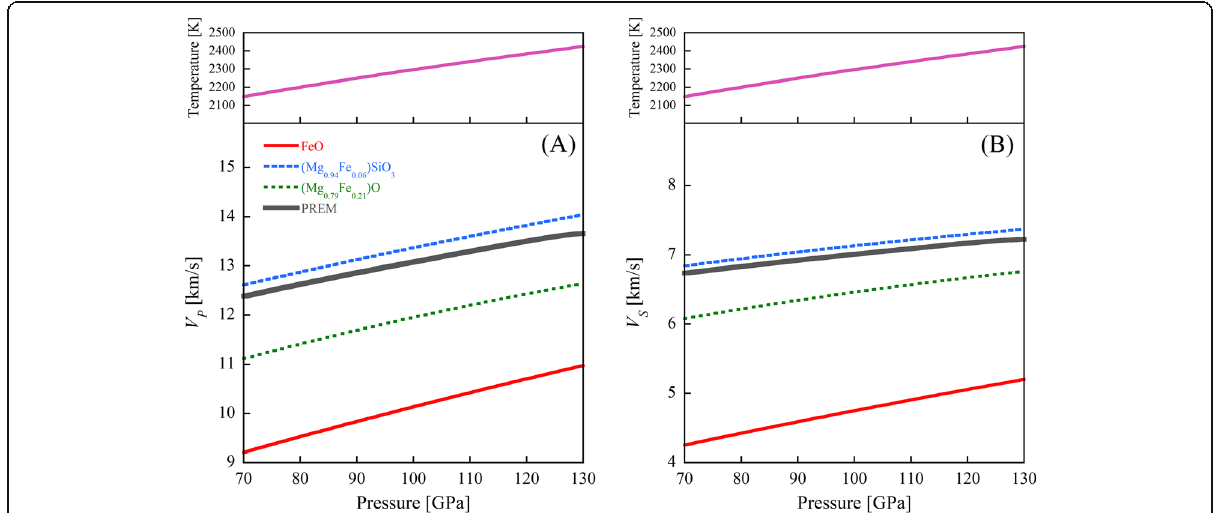
Fig. 6 Sound velocities of wüstite under lower mantle conditions. The V P ( a ) and V S ( b ) profiles were calculated along the mantle geotherm (Brown and Shankland 1981). The red solid line represents the B1-FeO values obtained in this study. The dashed and dotted lines represent bridgmanite ( X